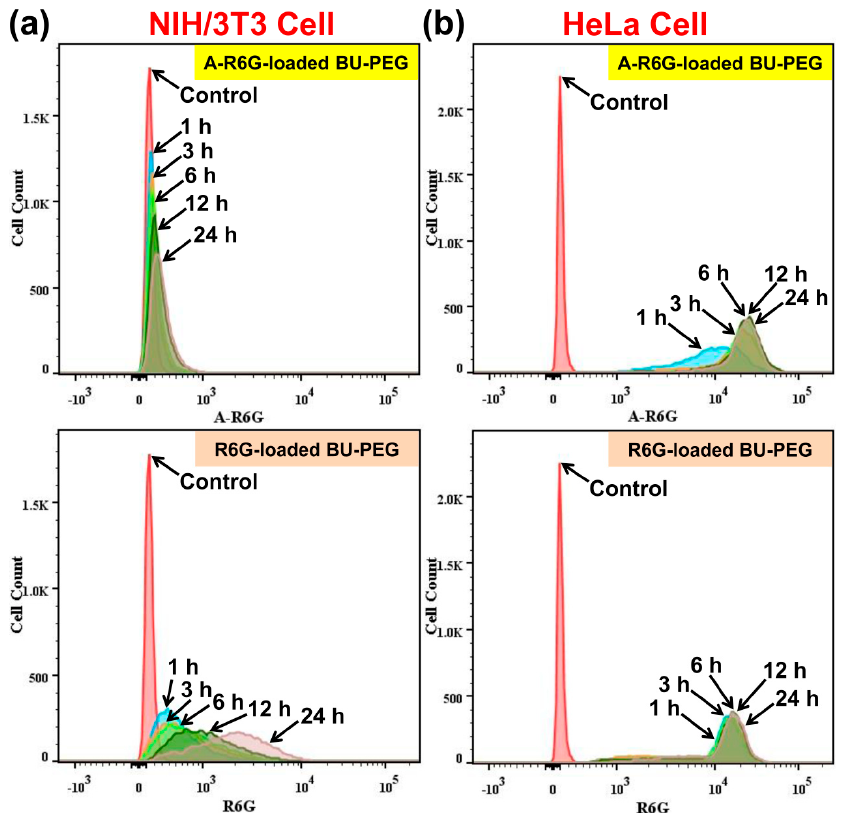
Figure 5. Flow cytometry histograms of ( a ) NIH/3T3 cells and ( b ) HeLa cells cultured with A-R6G-loaded or R6G-loaded BU-PEG nanogels at normal physiological conditions (pH 7.4 and 37 °C) for 1, 3, 6, 12, or 24 h.